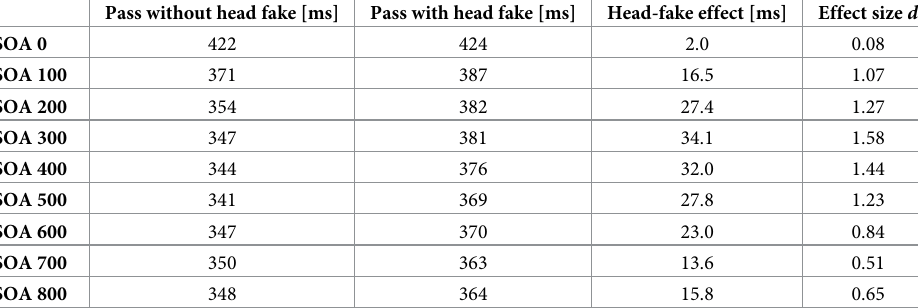
Table 1. Mean reaction times and head-fake effect in milliseconds and effect size for each SOA. Pass without head fake [ms] Pass with head fake